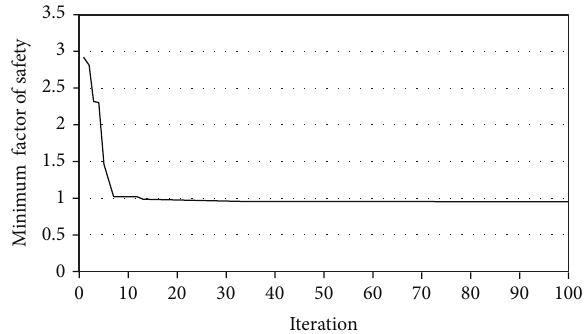
Figure 19: Minimum FOS versus iterations in example problem 2.